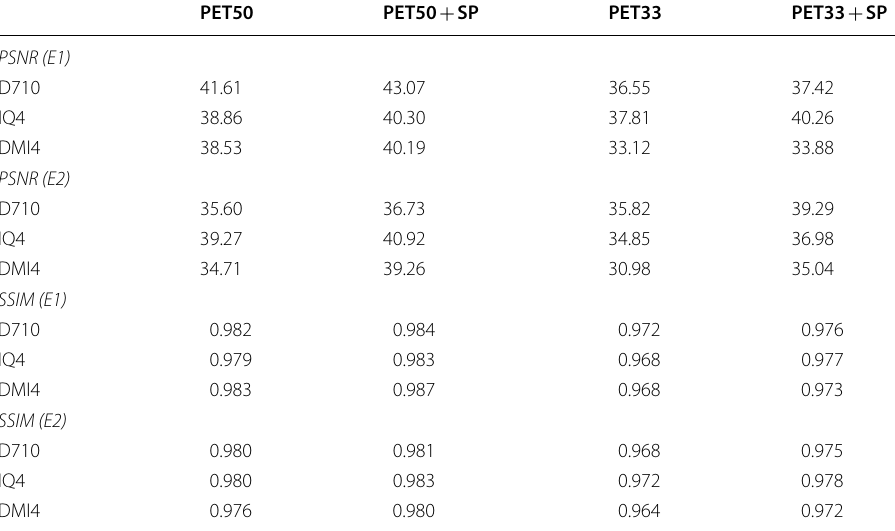
SubtlePET processing increase the PSNR & SSIM in every instance i.e., PET50 & PET33